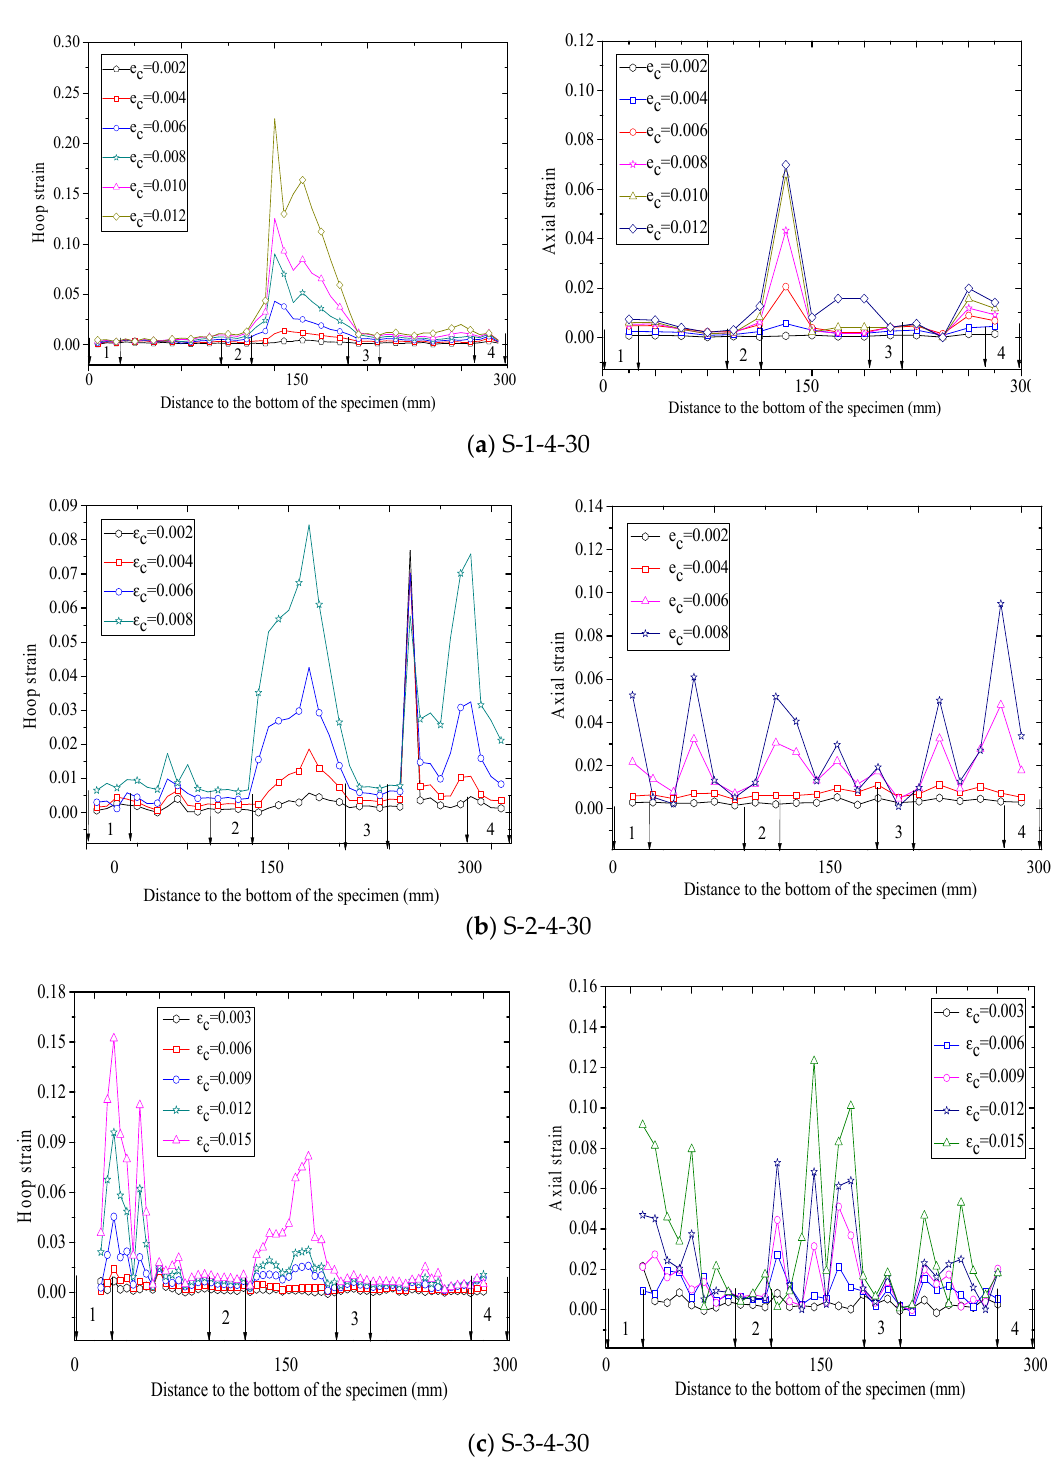
Figure 11. Strain distribution along the column height (specimens wrapped with four strips).